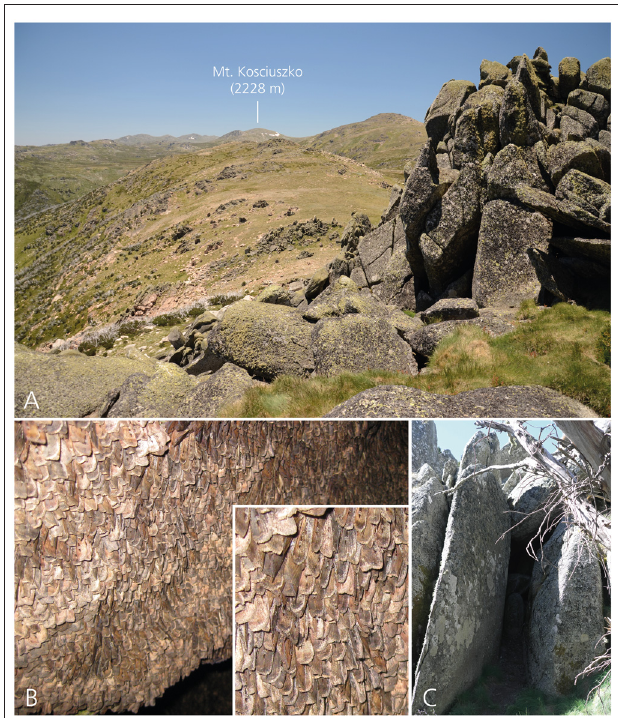
FIGURE 3 | Bogong moth estivation. (A) The typical terrain of the Main Range of the Snowy Mountains, seen in early January from the summit of South Ramshead (2052 m), looking north towards Mt Kosciuszko, Australia’s highest mountain (2228 m). The landscape of treeless grassy meadows is dotted with complex rock tors, periglacial boulder fields and boulder streams, some of which provide estivation sites for Bogong moths. Photograph: Stanley Heinze. (B) Bogong moths estivating in a cave on South Ramshead (inset: close-up). Photograph taken by Eric Warrant in late December. (C) A typical cave entrance within a rocky tor on the summit of Mt Gingera (1857 m) in the Brindabella Ranges on the border between NSW and the ACT. Mt Gingera is the northernmost known site for Bogong moth estivation. Photograph: Eric